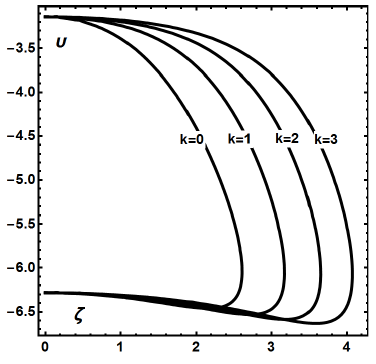
Figure 5: The influence of the parameter k on the distribution of eigencurves for rectangular plates with simply supported edges.